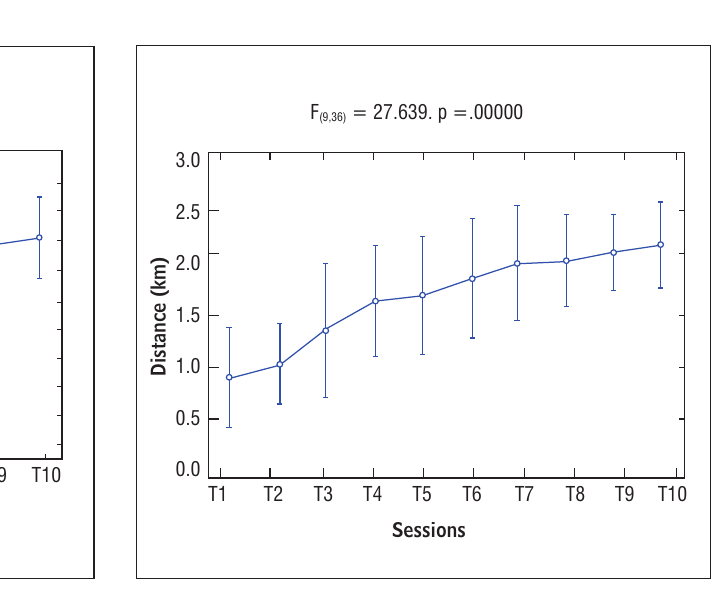
Figure 2 - Mean and confidence intervals of walking dis- tance (in km) over the course of the 10